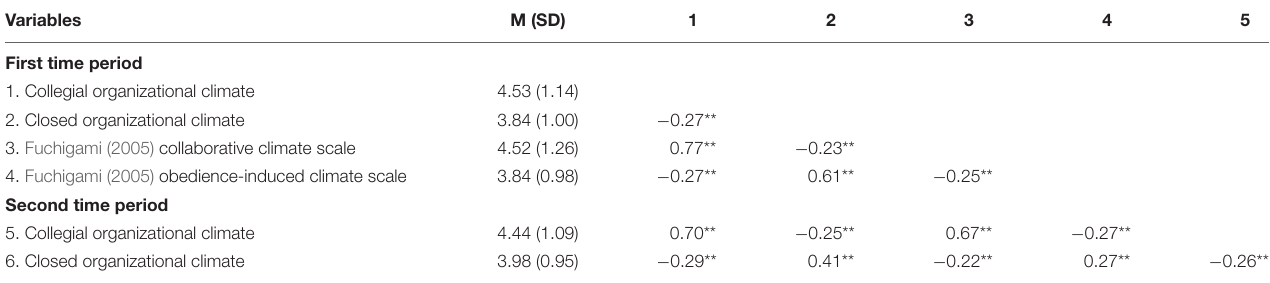
TABLE 2 | Descriptive statistics and zero-order correlation coefficients among related variables in Study 1.